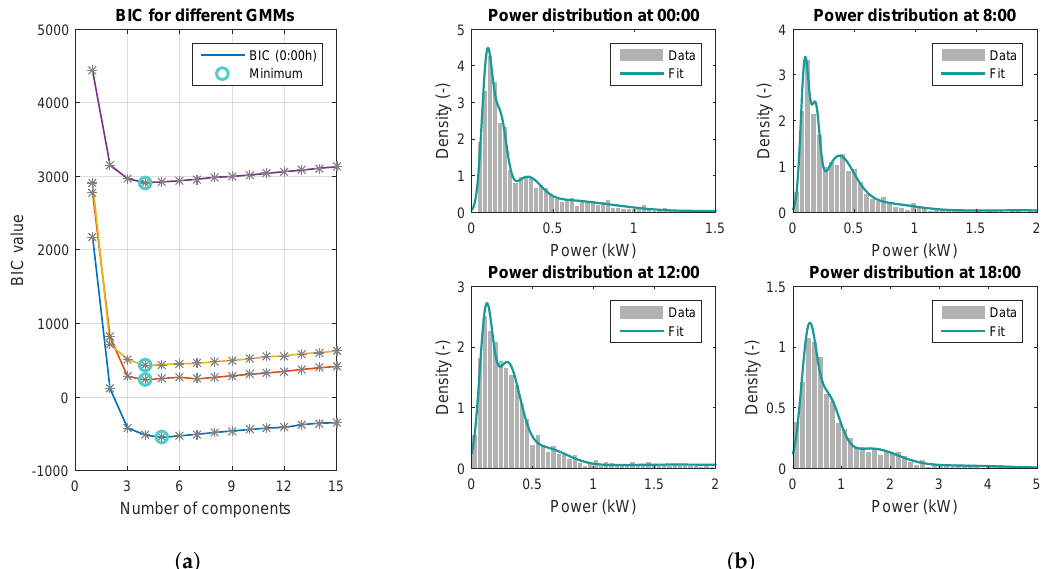
Figure 3. Fitting of mixture models to measurement data at four time intervals. ( a ) The Bayesian Information Criterion (BIC) values of the Gaussian mixture models (GMMs) for an increasing number of components. ( b ) PDFsof data and model fit using the optimal number of